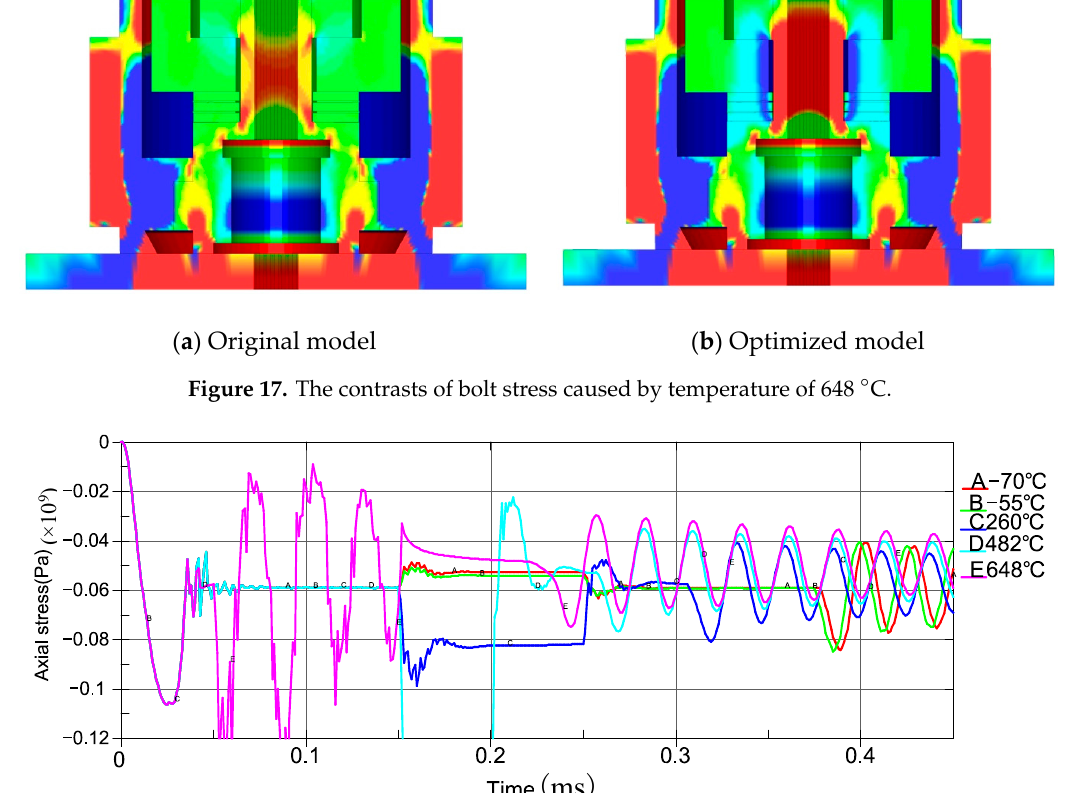
Figure 18. Average axial stress with respect to time under different temperature in optimized design.